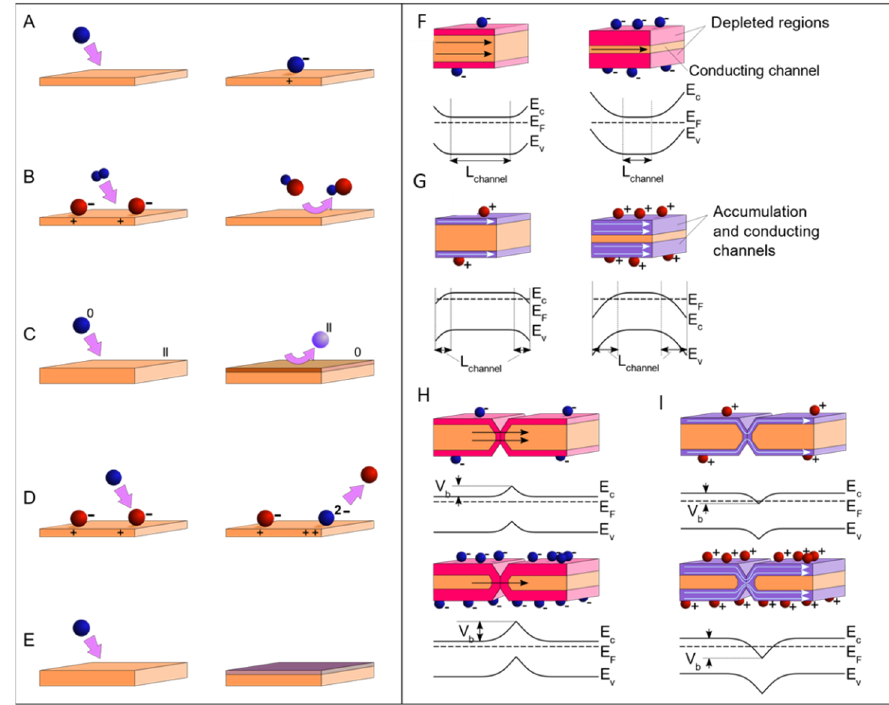
Figure 2. Left: Different analyte–sensor interaction processes: ( A ) direct charge transfer though ionosorption, ( B ) catalytic decomposition of the analyte and chemical reaction with other adsorbed species, ( C ) redox reactions between the analyte and the sensor surface, ( D ) competition for the same adsorption sites with other adsorbed species, and ( E ) (reversible) chemical reaction. Right: effect of space charge regions on the sensor conductivity (for an n-type semiconductor): ( F , G ) formation of conduction channels and ( H , I ) formation of potential junction barriers between two adjacent grains.